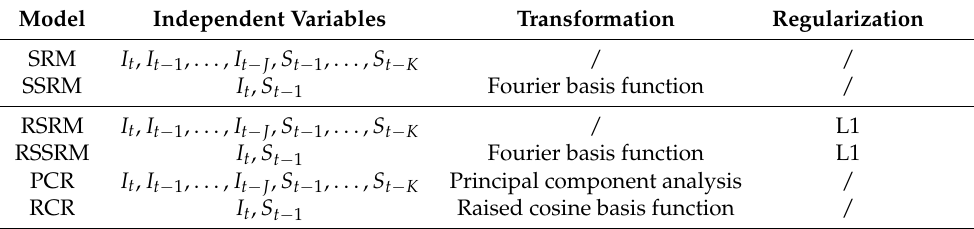
Table 1. Attributes of neuron